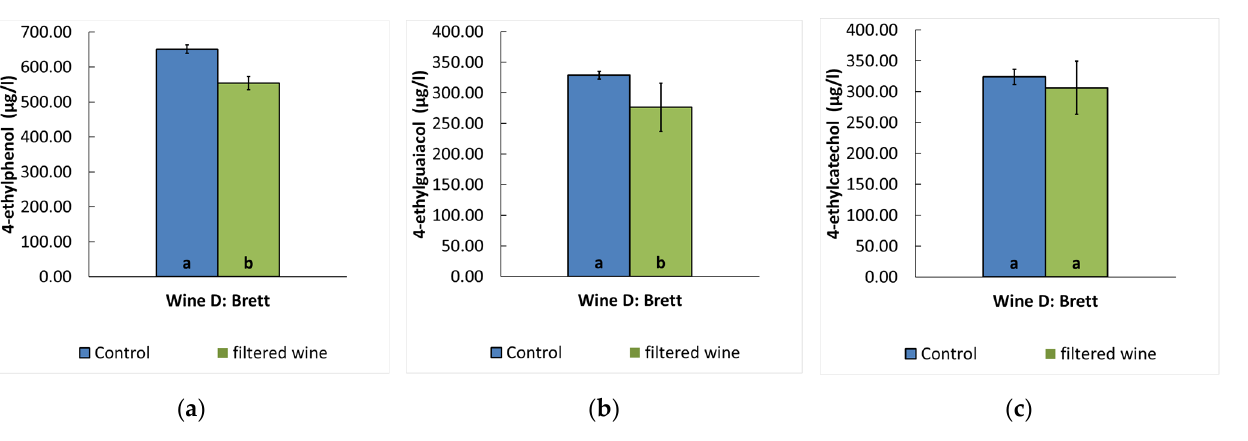
Figure 8. Reduction in impact substances of “animal” phenolic aromas by filtration with a prototype of the company Filtrox in comparison with the control sample in the large-scale test. Wine D was spiked with impact compounds of the “animal” phenolic character (Brett): ( a ) 4-ethylphenol; ( b ) 4-ethylguaiacol; ( c ) 4-ethylcatechol. Significance test by means of simple ANOVA. Same letters mean no significant difference based on the significance level p ≤ 0.05 with alphabetical order, starting with a (smallest value) to b (largest value).